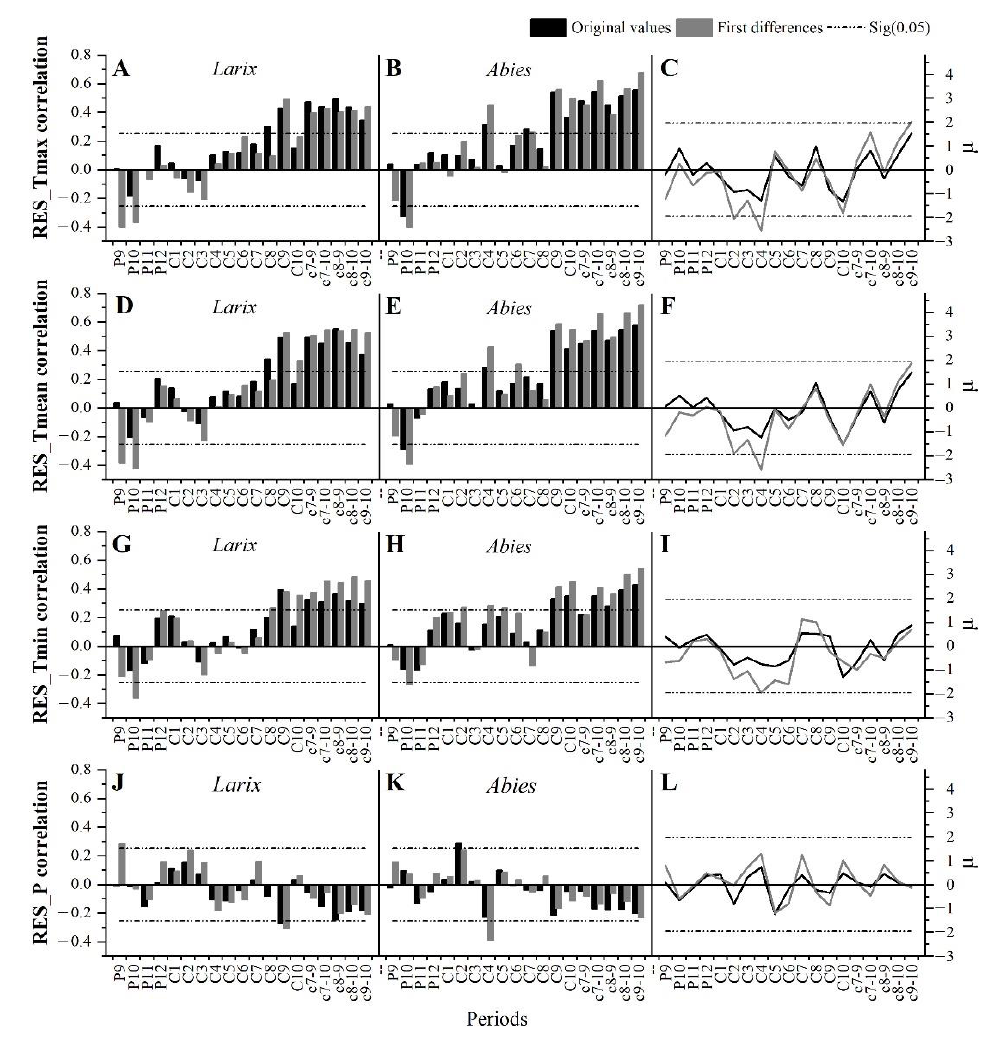
Figure 4. Correlation between MXD of different tree species and CRU TS 4.04 climatic variables during different periods (1951–2019). Correlation between ( A ) T max , ( D ) T mean , ( G ) T min , ( J ) P, and RES chronologies of L. speciosa . Correlation between ( B ) T max , ( E ) T mean , ( H ) T min , ( K ) P, and RES chronologies of A. delavayi . Significance of the different correlations with ( C ) T max , ( F ) T mean , ( I ) T min , and ( L ) P between the MXD of the two species. The absolute values of statistic ( µ ) less than 1.96 (dashed line) indicates the same correlation with climate for MXD of the two species.